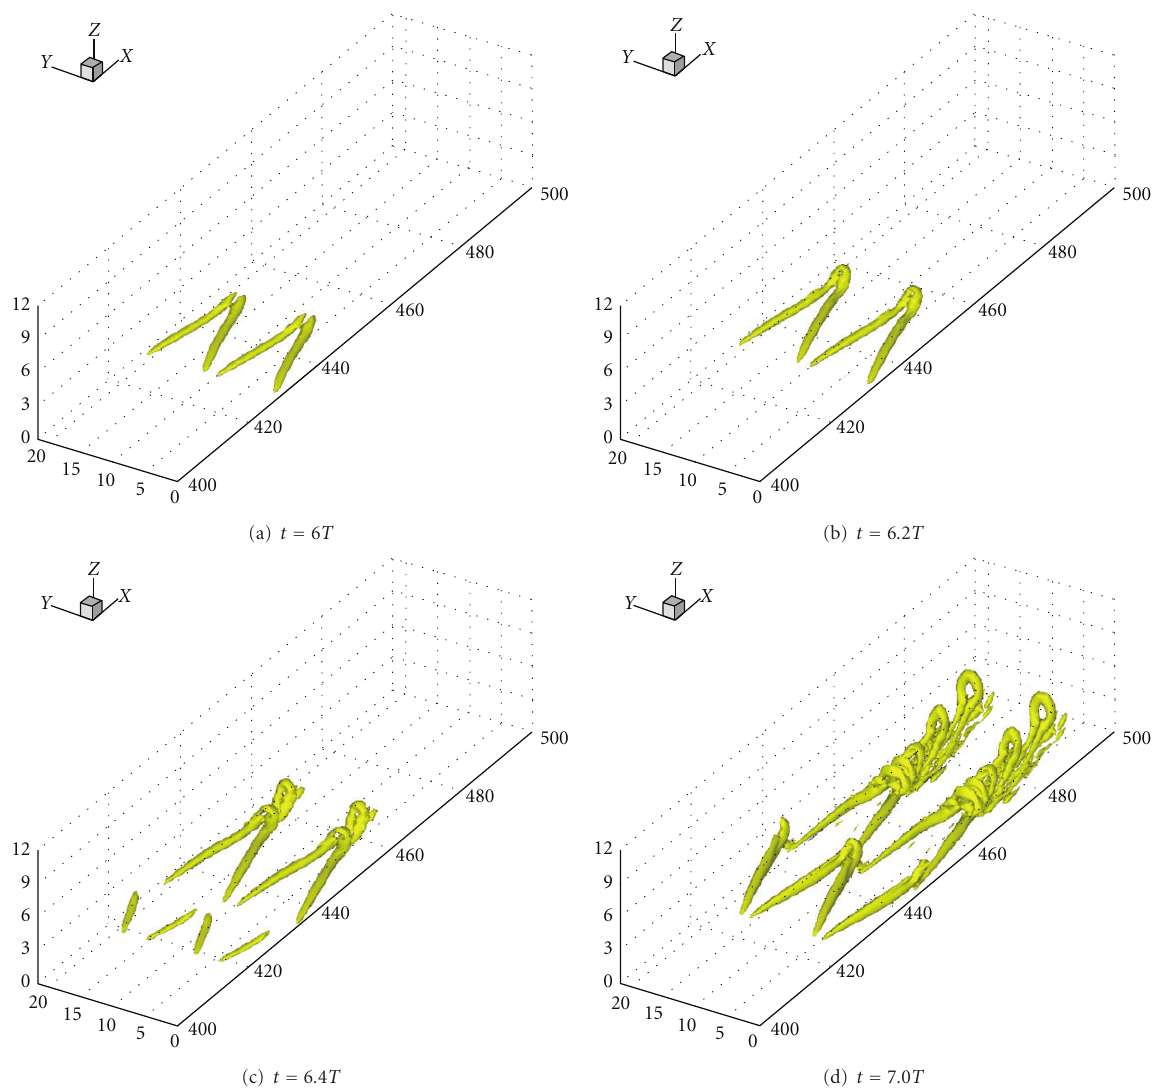
Figure 10: Evolution of vortex structure at the late-stage of transition (where T is the period of T - S wave).